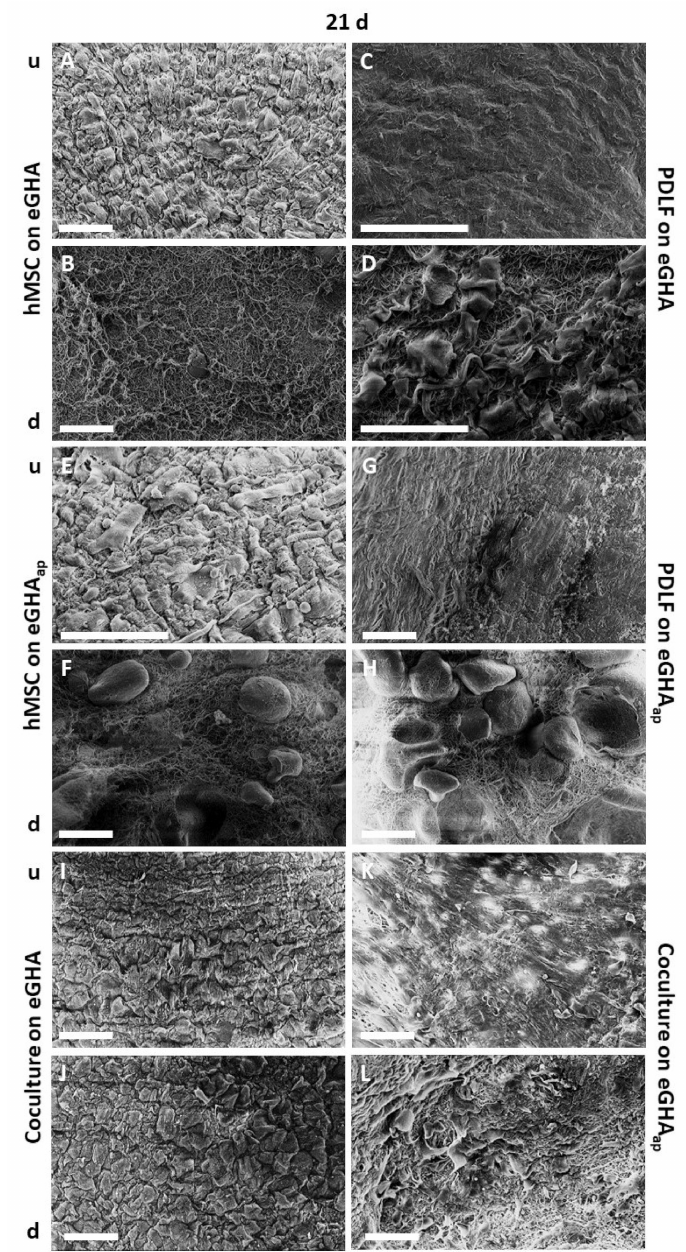
Figure 2. Scanning electron micrographs of eGHA/eGHA ap scaffolds after 21 d. Illustrated is always the surface of the scaffolds, indicating the different morphologies of the respective cell types under study which from time to time reveal the nanofibers on the underside of the scaffolds ( B , D , F , H , J , L ). hMSCs ( A , B , E , F ), PDLFs ( C , D , G , H ), or cocultures of both ( I – L ) were seeded on either eGHA ( A – D , I , J ) or eGHA ap scaffolds ( E – H , K , L ) and prepared for scanning electron microscopy (SEM) analysis after 21 d. The top sides (u) of the monocultures ( A , C , E , G ) were densely populated with either hMSCs or PDLFs, while the bottom sides (d) ( B , D , F , H ) illustrated the geometric configurations of the nonwovens and were barely populated by cells, as expected. In the cocultures, (u) were populated by hMSCs ( I , K ) and (d) with PDLFs ( J , L ). Details are given in the main text. All scaffolds, irrespective of the presence of additional porosity, were densely covered with the indicated cells, proving the overall suitability of the eGHA/eGHA ap nonwovens for the adhesion and spreading of periodontal fibroblasts and mesenchymal stem cells. The cell morphologies could be described as polygonal or spindle-like. Scale bars represent 100 µ